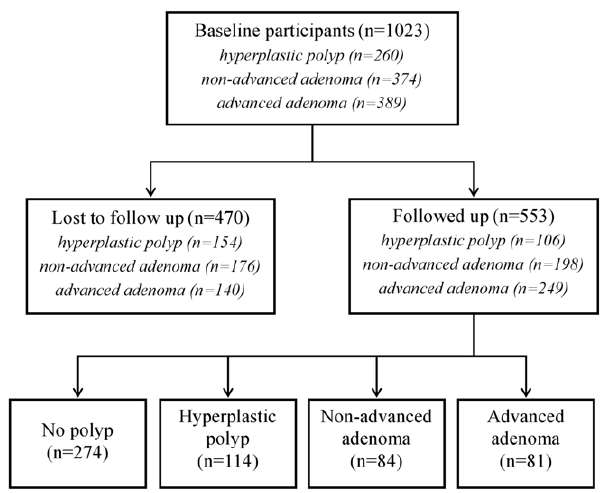
Figure 1. Flow diagram for the colorectal polyp recurrence